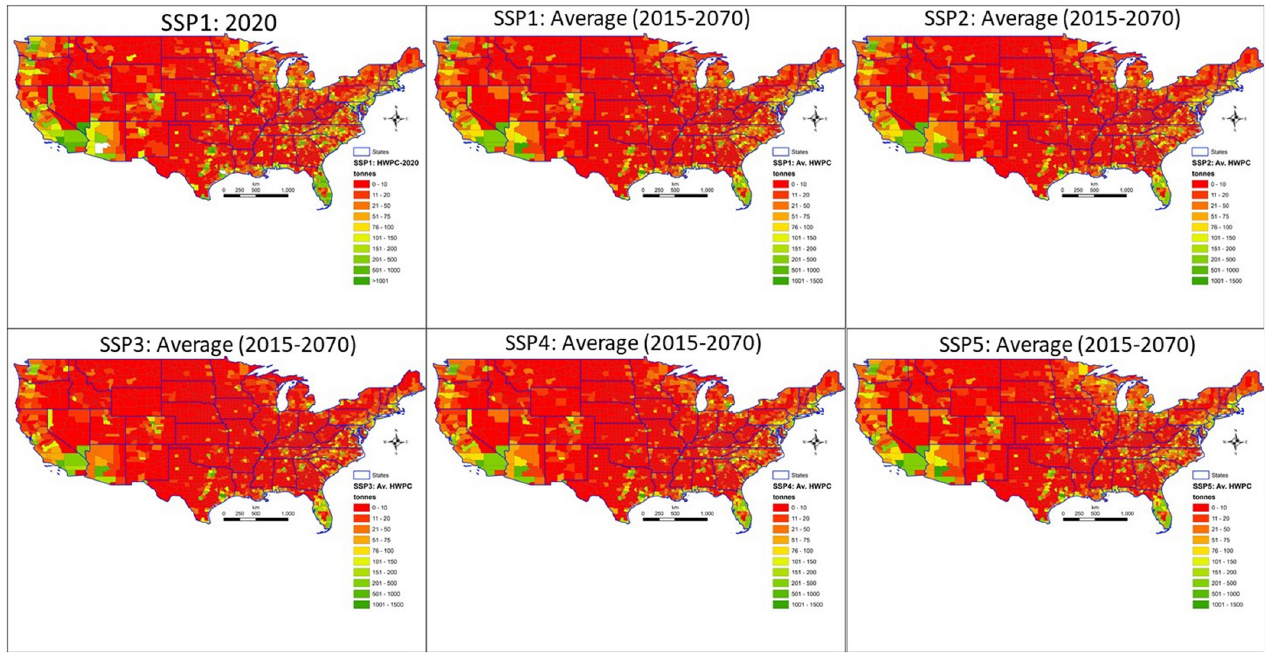
Fig 5. Projected average annual changes in harvested wood products carbon stocks (thousand t CO 2 e) contained in U.S. single-and multifamily housing units in use and in landfills after demolition, 2015–2070, by county by Shared Socioeconomic Pathway. Figure was created by the authors in ESRI’s ArcGIS 10.5 software (https://www.esri.com). The USDA-NRCS topo (https://gdg.sc.egov.usda.gov/GDGHome.aspx) was used as a basemap (NRCS Counties by State, and NRCS States by State) in this